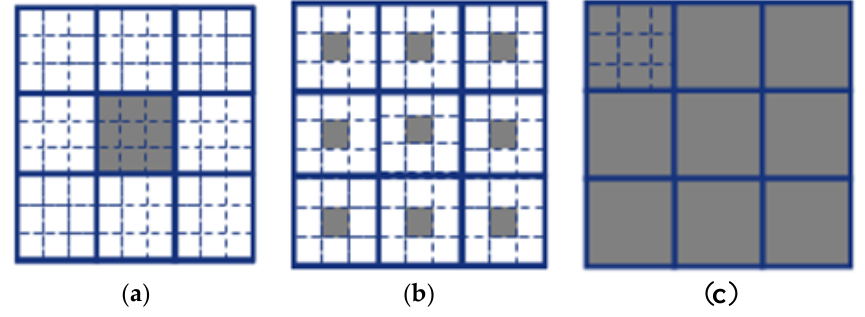
Figure 5. The multi-scale feature extraction modes. ( a ) original mode; ( b ) central mode; ( c ) average mode.